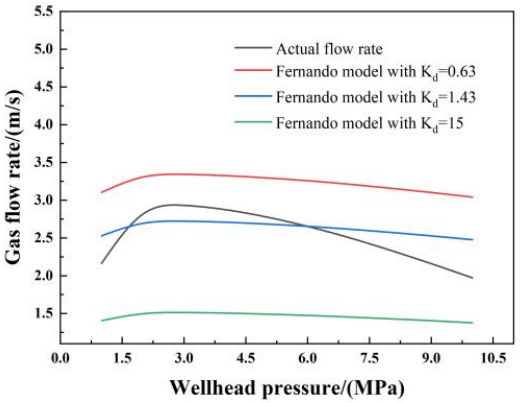
Figure 5. Actual flow rates and liquid-carrying flow rates in the inclined part of the well.